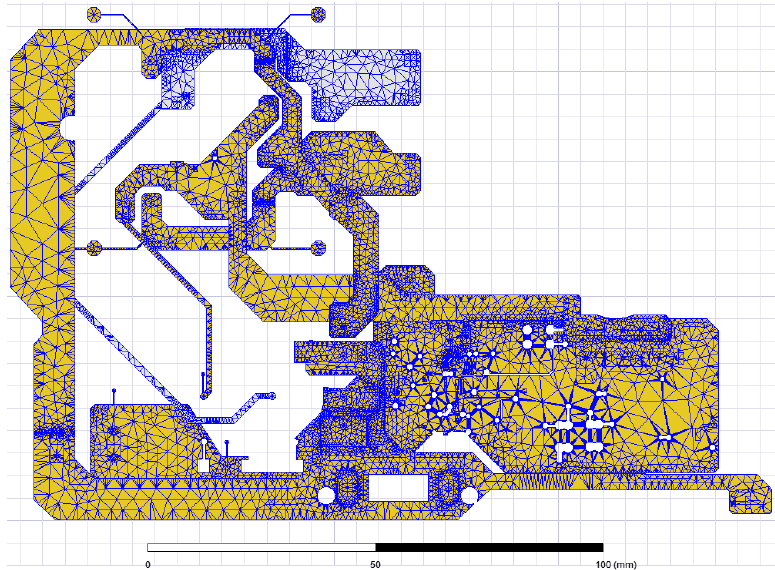
Figure 14. View of the Q3D model mesh.